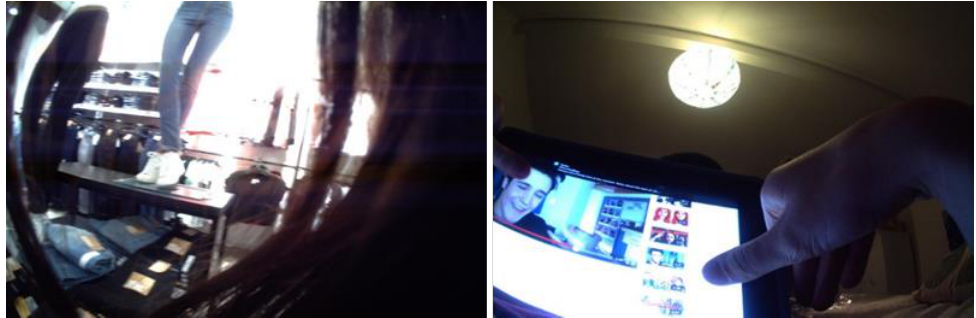
Figure 4. Clothes shopping and social media images prompted discussions around body image and the negative perceptions of carbohydrates.